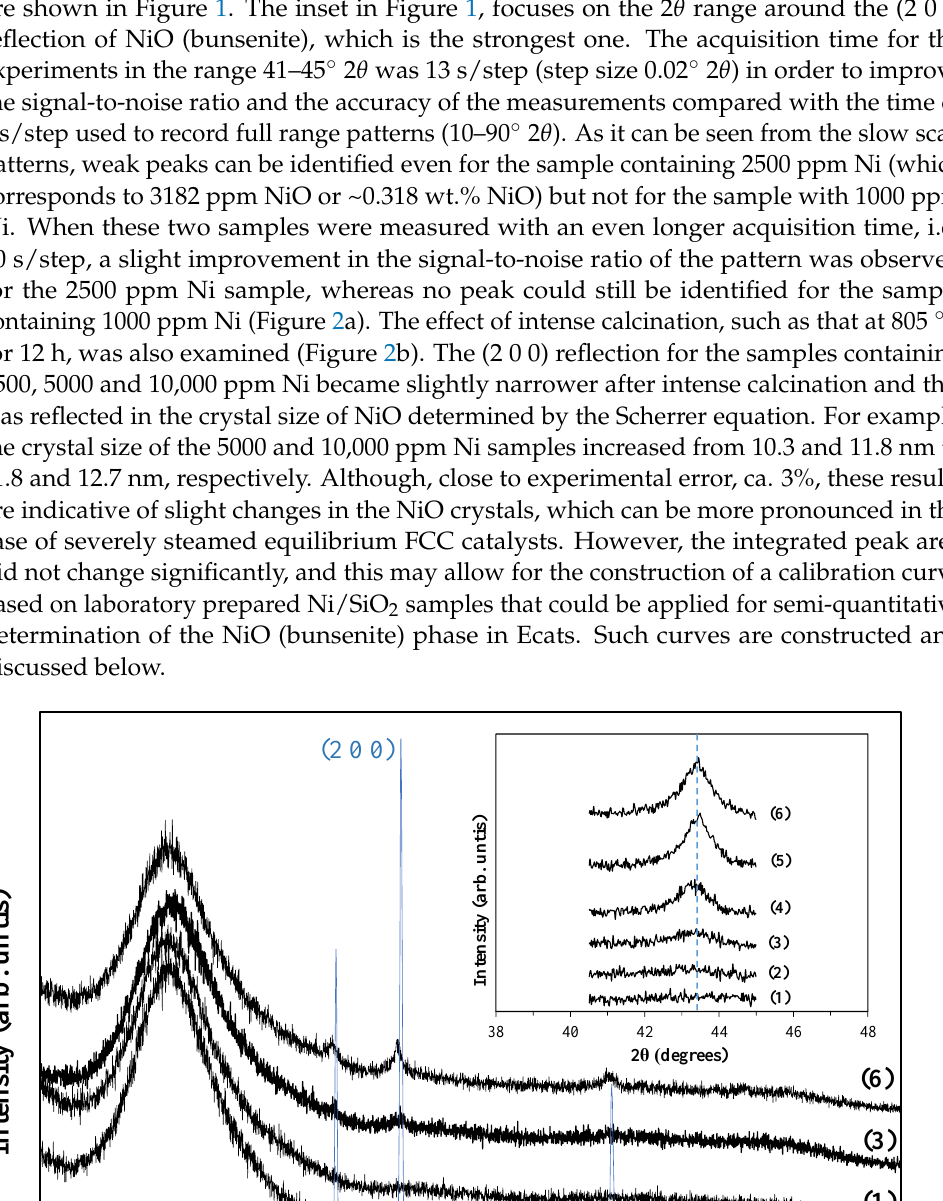
Figure 2. ( a ) Effect of pxrd scan conditions on the quality of the obtained patterns: Patterns (1xs) and (2xs) refer to the samples SiO 2 -CH-Ni-oc- X with 1000 and 2500 ppm Ni, respectively, for which an acquisition time of 30 s/step was applied, compared with the corresponding patterns ( 1 ) and ( 2 ),